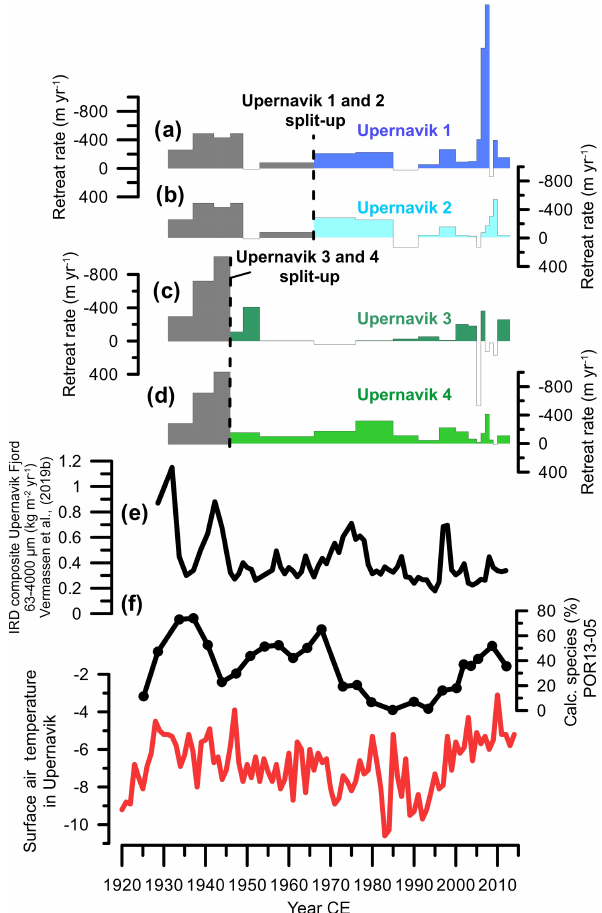
Figure 8. Comparison of retreat rates of Upernavik Isstrøm’s glaciers (Andresen et al., 2014) with reconstructed inflow of At- lantic water to Upernavik fjord (this study) and measured surface air temperatures in Upernavik (Cappelen, 2011). (a–d) Retreat rates of Upernavik 1, Upernavik 2, Upernavik 3, and Upernavik 4, re- spectively (Andresen et al., 2014). Grey colours indicate periods when the northern glaciers and southern glaciers were still joined together, stippled lines indicate when these split up. (e) Composite record of IRD variability based on multiple sediment cores in Uper- navik Fjord (Vermassen et al., 2019b). (f) Percentage of calcareous foraminifera in core POR13-05, used as a proxy for Atlantic water inflow. (g) Observed surface air temperatures in Upernavik (Cappe- len,